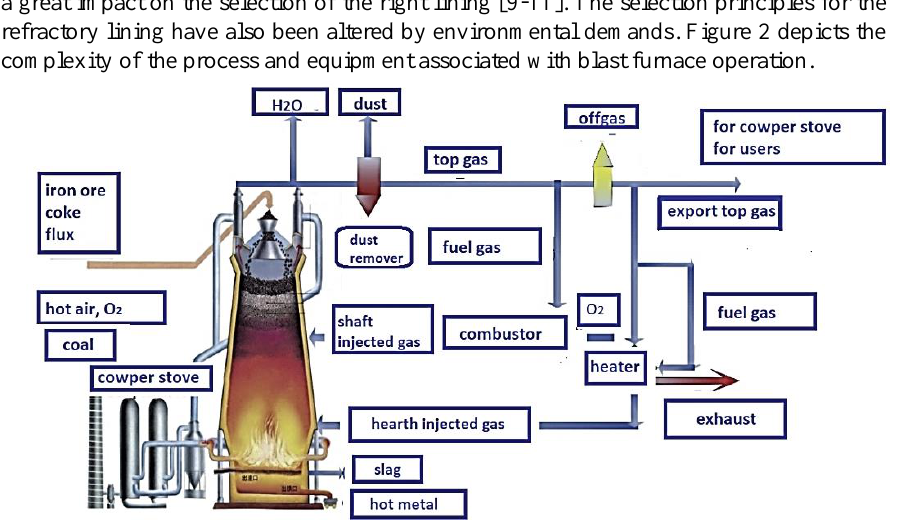
Fig. 2. Blast furnace process flow